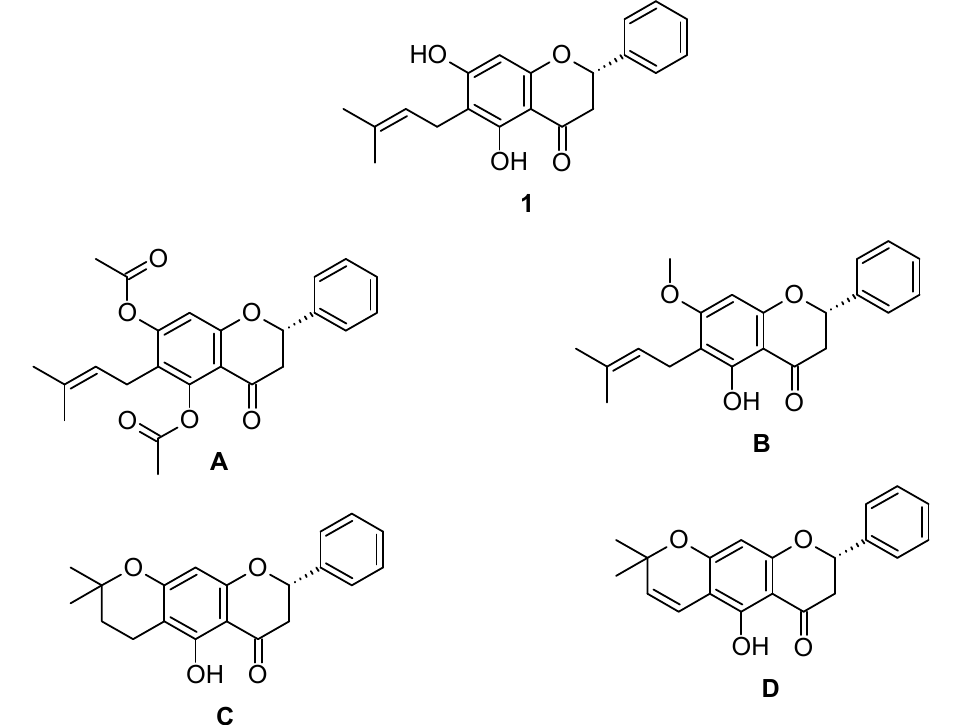
Figure 1 . Chemical structures of studied compounds. (2 S ) ‐ 5,7 ‐ dihydroxy ‐ 6 ‐ (3 ‐ methyl ‐ 2 ‐ buten ‐ 1 ‐ yl) ‐ 2 ‐ phenyl ‐ 2,3 ‐ dihydro ‐ 4H ‐ 1Benzopyran ‐ 4 ‐ one ( 1) ; (2 S ) ‐ 5,7 ‐ bis(acetyloxy) ‐ 6 ‐ (3 ‐ methyl ‐ 2 ‐ buten ‐ 1 ‐ yl) ‐ 2 ‐ phenyl ‐ 2,3 ‐ dihydro ‐ 4 H ‐ 1 ‐ Benzopyran ‐ 4 ‐ one ( A ); (2 S ) ‐ 5 ‐ hydroxy ‐ 7 ‐ methoxy ‐ 6 ‐ (3 ‐ methyl ‐ 2 ‐ buten ‐ 1